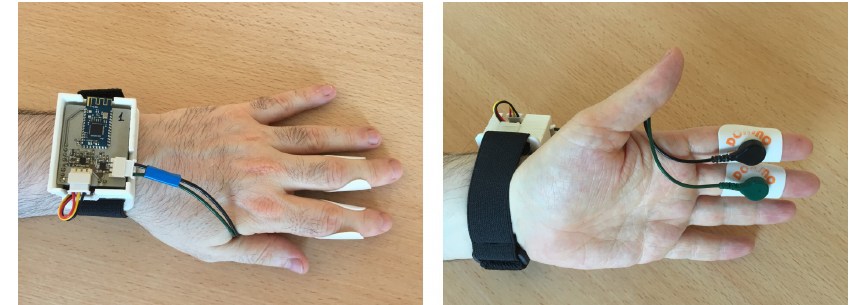
Figure 1. Prototype of the wearable. ( Left ) The wearable is put in the wrist of the non-dominant hand. ( Right ) The electrodes are attached to the medial phalanges in the palm sides of index and middle fingers.